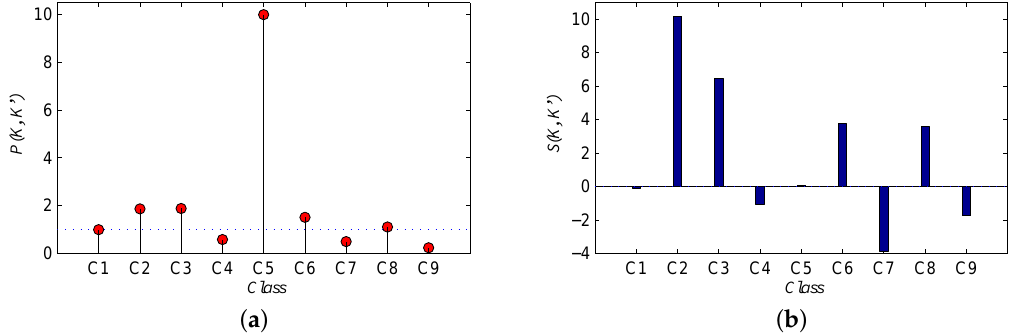
Figure 13. Curves of ( a ) P K , K (cid:48) (the ratio of the accuracy improvement with the kernel k to that with another kernel k (cid:48) ) and ( b ) S K , K (cid:48) (the D-value of the superiority of the kernel k over another kernel k (cid:48) ) for the Power-SAM-RBF kernel versus the RBF kernel for the Indian Pines